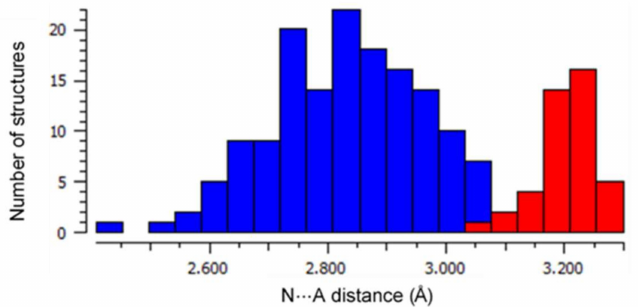
Figure 3. A histogram of the frequency of N ··· A distances for H-bonding N-H ··· A close contacts within porphyrin acid structures in the CSD with A = − OR (in blue) and A = Cl − (in red). Median distances for each of these groups (A = O, 2.846 Å; A = Cl, 3.203 Å) are indicative of charge-assisted H-bond